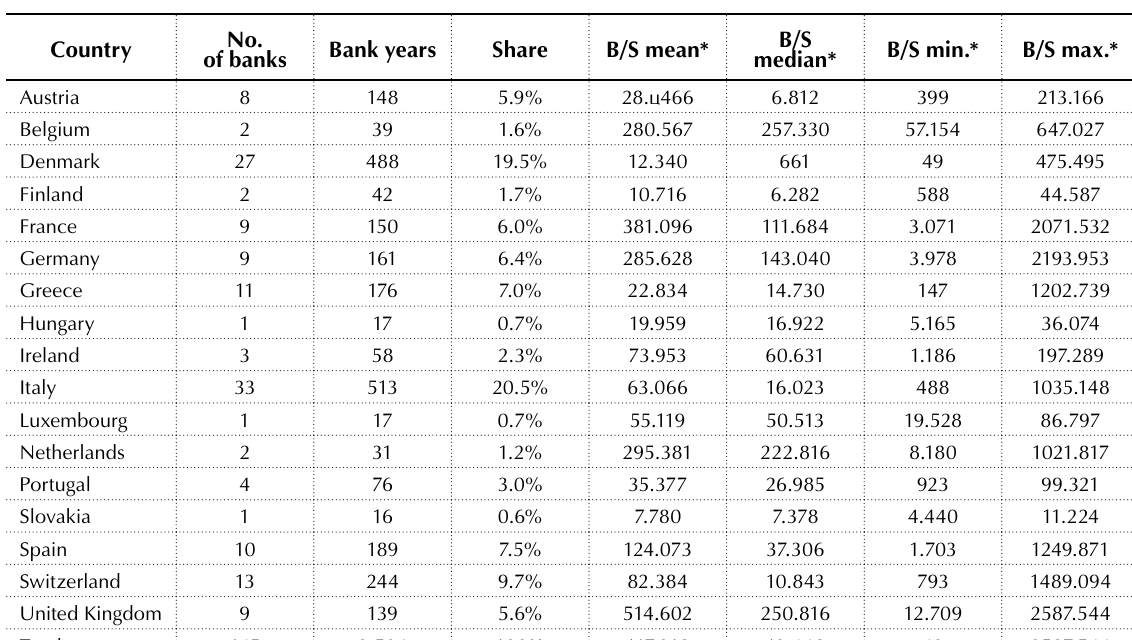
Table 3. Data sample and bank